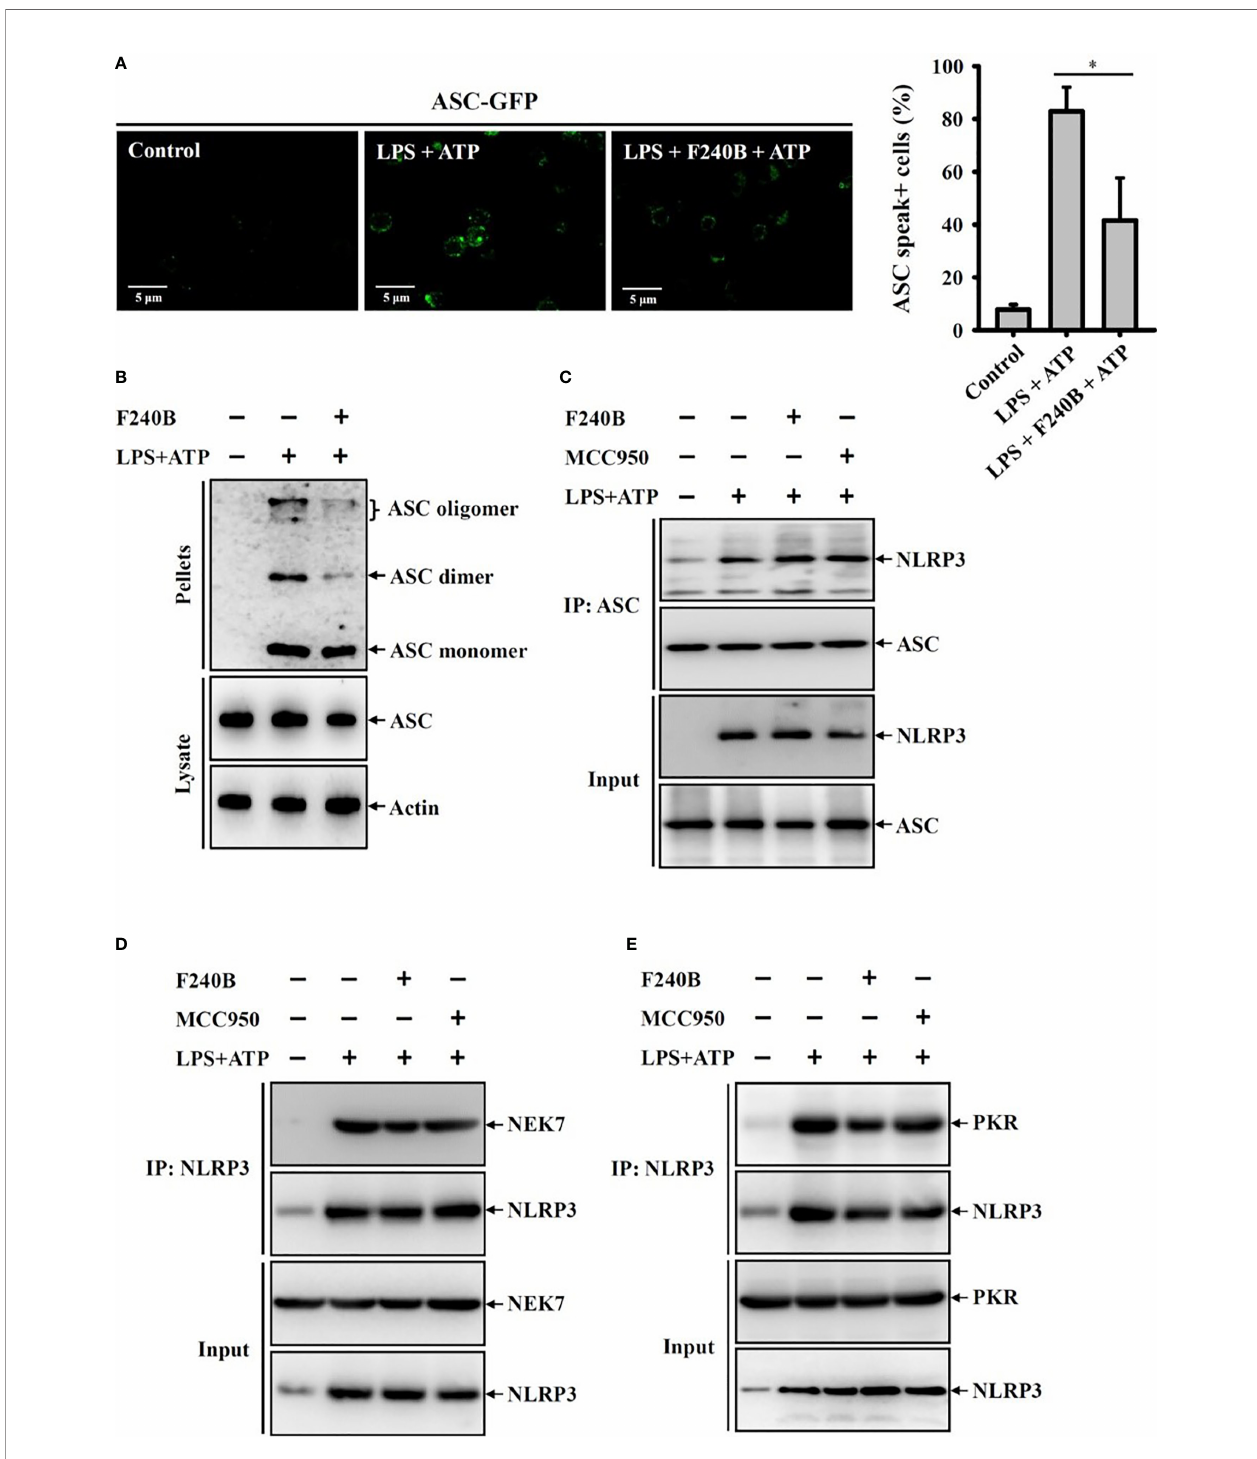
FIGURE 8 | F240B inhibits ASC oligomerization. (A) ASC-GFP expressed J774A.1 macrophages or (B) J774A.1 macrophages were incubated with 1 m g/ml LPS for 5 h followed by incubated with 1 m M F240B for 3 h. Cells then incubated with 5 mM ATP for 0.5 h. The ASC speck formation was analyzed by fl uorescent microscope (A) , or the cell lysates were crosslinked by disuccinimidyl suberate and ASC oligomerization was analyzed by Western blotting (B) . (C – E) J774A.1 macrophages were incubated with 1 m g/ml LPS for 5 h followed by incubated with 1 m M F240B or 0.1 m M MCC950 for 3 h. Cells then incubated with 5 mM ATP for 0.5 h. The interaction between NLRP3 with ASC (C) , NEK7 (D) or PKR (E) were analyzed by immunoprecipitation and Western blotting assay. The percentage of ASC speck positive cells are expressed as the mean ± SD of three separate experiments. * indicates a signi fi cant difference at the level of p <